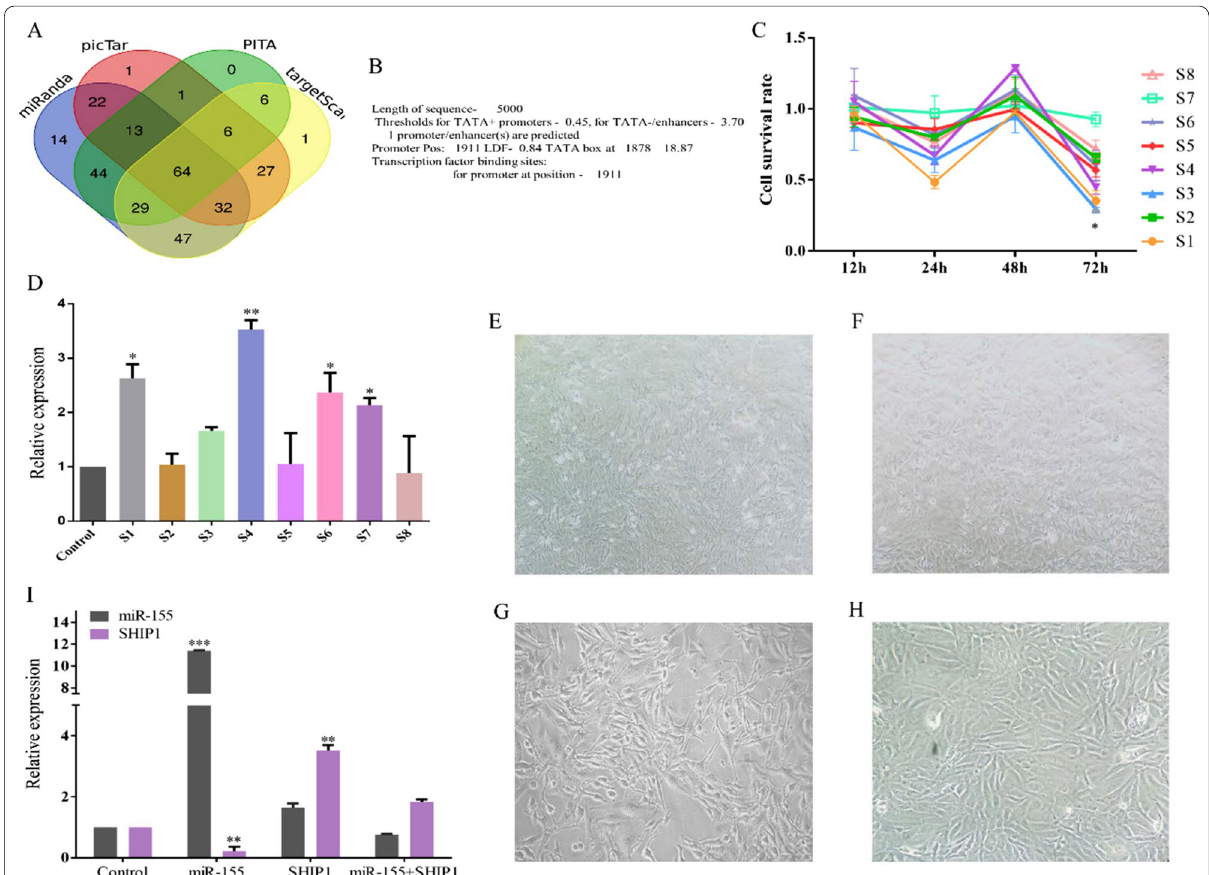
Fig. 7 A Relationships between the numbers of miR-155 target genes predicted by the four tools used in this study. B Prediction of the transcription start site in the 5000 bases upstream of the 5’ end of the first exon of INPP5D. C Cell survival rates of HUVECs treated with nucleic acid NFs S1–S8 activating SHIP1 at 12 h, 24 h, 48 h, and 72 h (*P < 0.05 vs. control). D SHIP1 expression in cells treated with nucleic acid NFs S1–S8 for 72 h (*P < 0.05 vs. control; **P < 0.01 vs. control). E Control cells cultured in the absence of NFs (magnification,4 ). F Cell state at 72 h after miR-155 × expression activation (magnification, 4 ). G Cell state at 72 h after SHIP1 expression activation (magnification,10 ). H Simultaneous activation of × × miR-155 and SHIP1 expression (magnification,10 ). I Relative expression levels of SHIP1 and miR-155 in HUVECs treated with NF-M5, NF-S4, NF-M5, × and NFs-S4 for 72 h (**P < 0.01 vs. control; ***P < 0.001 vs.